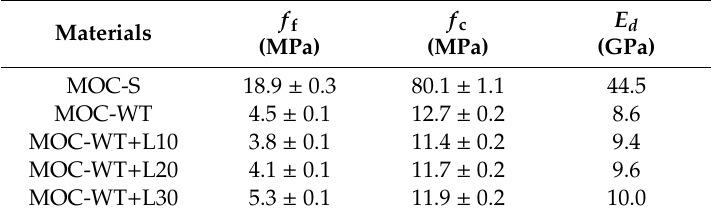
Table 5. Mechanical parameters of hardened